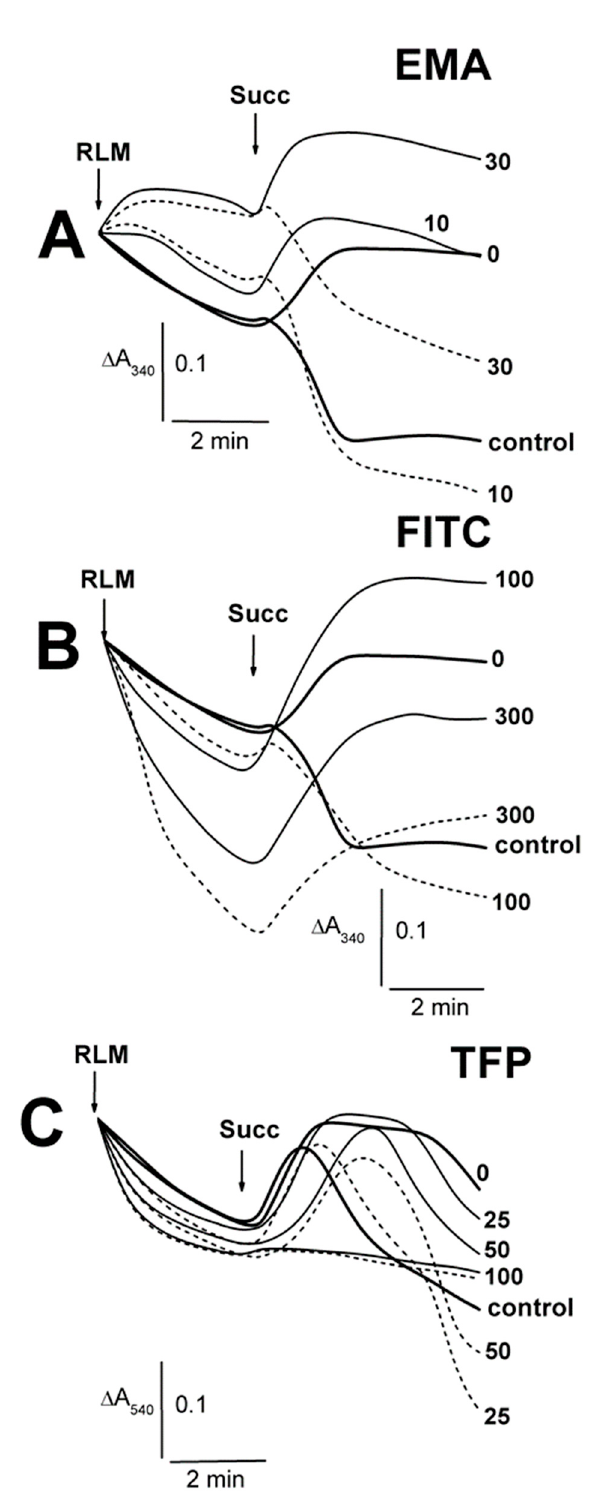
Figure 3. The influence of EMA, FITC and TFP on the Tl + -induced swelling of rat liver mitochondria. Mitochondria (1.5 mg/mL of protein) were injected into the medium A containing 75 mM TlNO 3 . The numbers on the right of the traces show concentrations ( µ M) of EMA ( A ), FITC ( B ), and TFP ( C ), which were injected into the medium before mitochondria. Additions of mitochondria (RLM) and 5 mM succinate (Succ) are shown by arrows. The medium was additionally supplemented by 50 µ M Ca 2+ (short dash traces). The bold traces show experiments free of Ca 2+ (0) or ones with Ca 2+ alone (control).